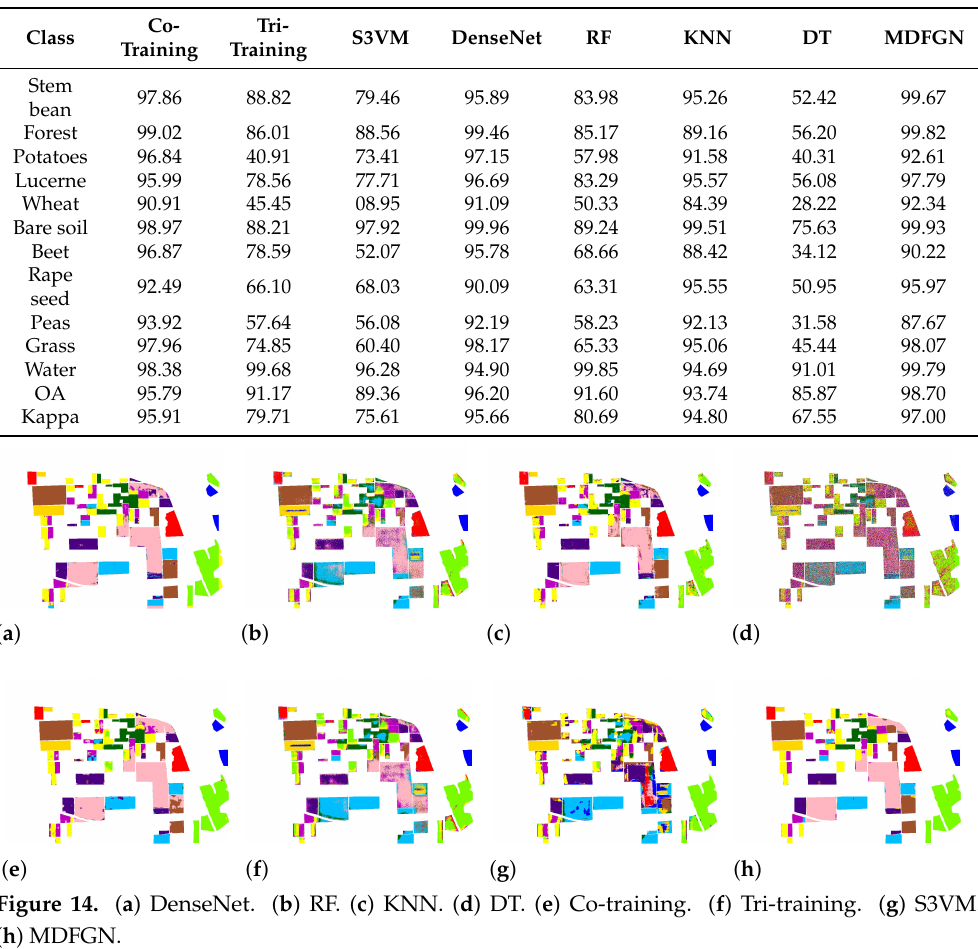
Table 3. Classification accuracy (%) for AIR-Flev data.